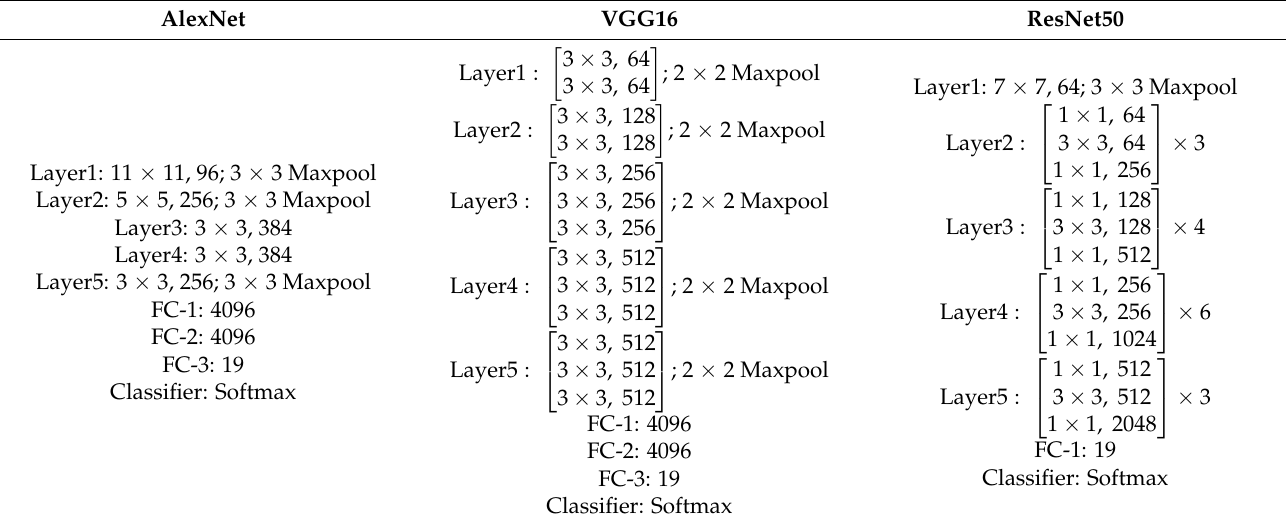
Table 7. Main parameters of classical convolutional neural